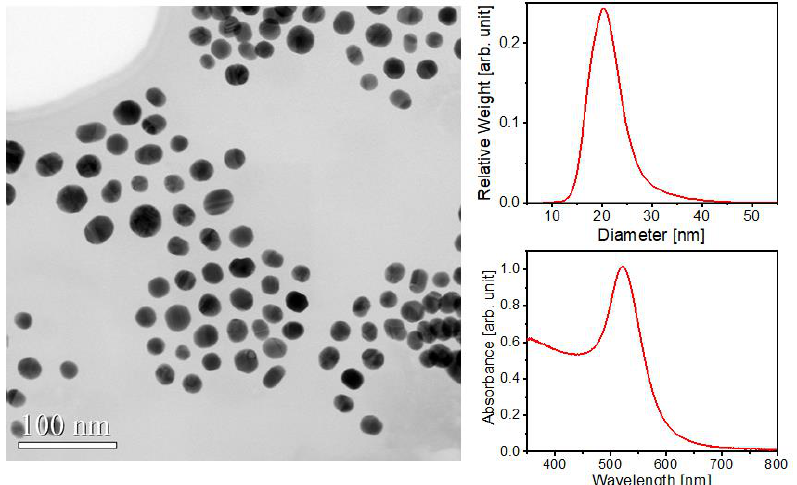
Figure 1. TEM image, size distribution, and UV–Vis absorption spectrum of the PLA-generated AuNPs.